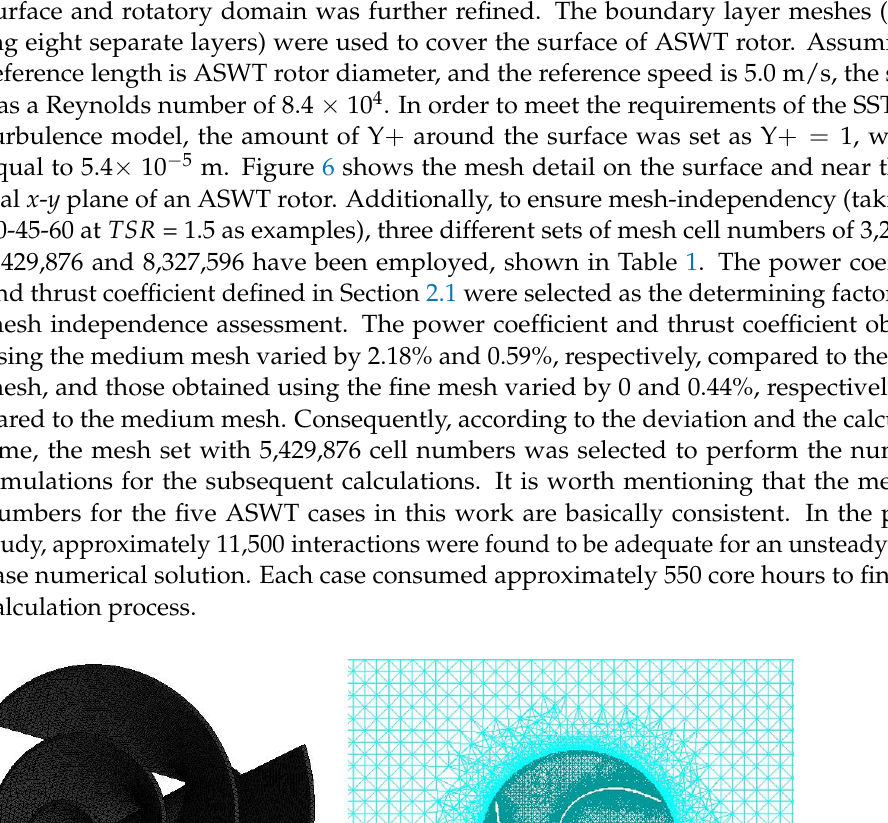
Figure 5. Calculation domain.